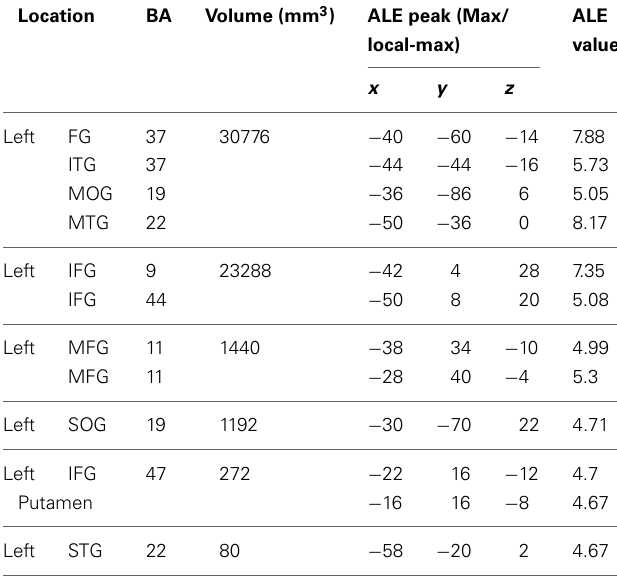
Table 4 | Results of Stage 1 of the IPPC analysis: Subject-based Activation Likelihood Estimates (ALE) for control participants.